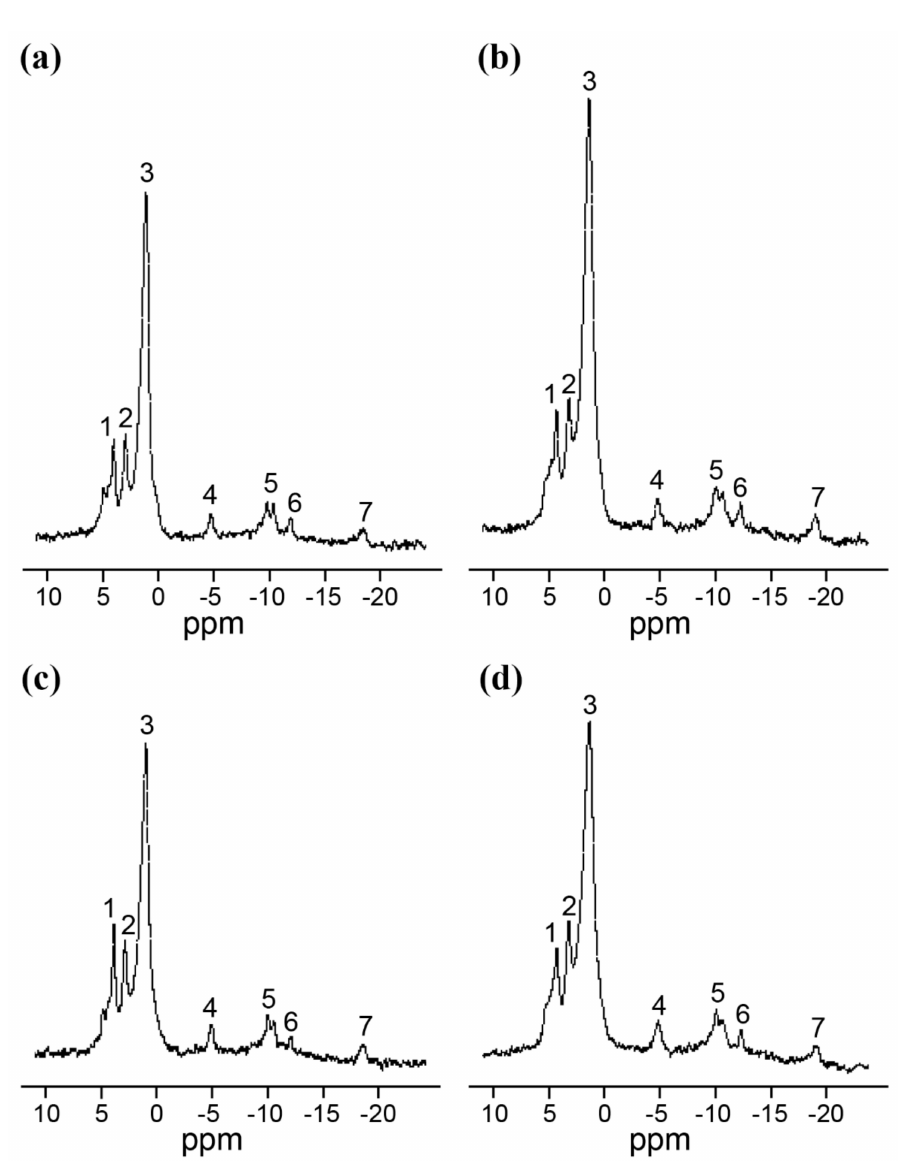
Figure 3. Representative 31 P-NMR spectra of R. sativus seeds incubated for 24 ( c , d ) and 48 h ( a , b ) in the absence ( a , c ) or in the presence ( b , d ) of 400 µ M of coumarin. The spectra were acquired with a 1 s recycle time and are the sum of 2000 scans. The resonance assignments are as follows: peak 1, phosphocholine; peak 2, cytoplasmic inorganic phosphate; peak 3, vacuolar inorganic phosphate; peak 4, γ -phosphate of NTP and β -phosphate of nucleoside diphosphate (NDP); peak 5, α -phosphates of NTP and NDP; peak 8, UDP-Glc and NAD(P)(H); peak 6, UDP-Glc; peak 7, β -phosphate of NTP. Chemical shifts are quoted relative to 85% H 3 PO 4 . In the three independent experiments, the resonance intensities differed by 15% at